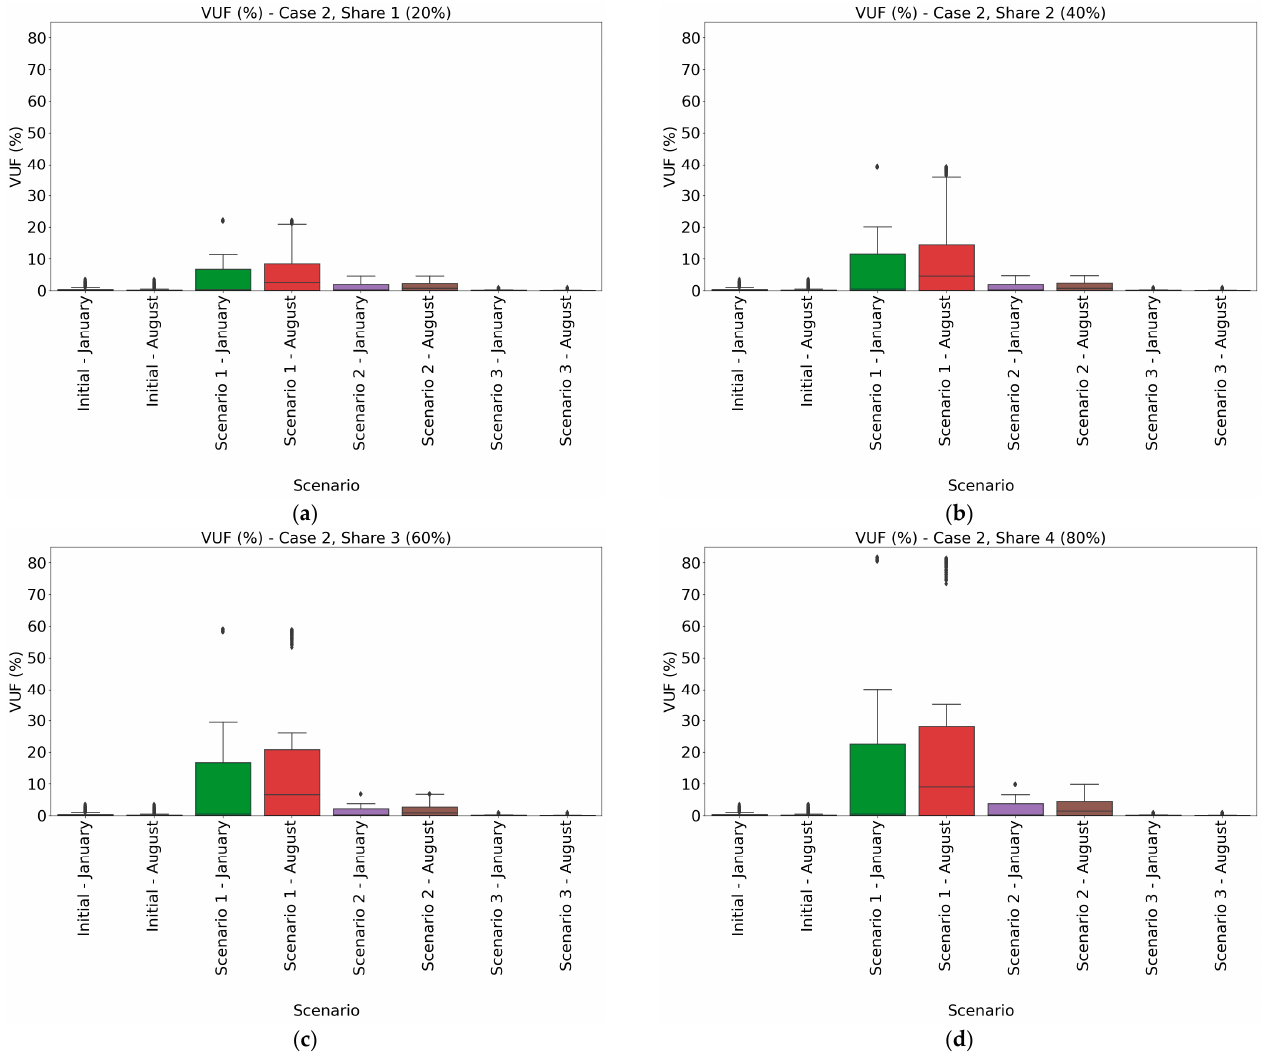
Figure 4. VUF (%)—Case 2; Share 1–Share 4; January, August.